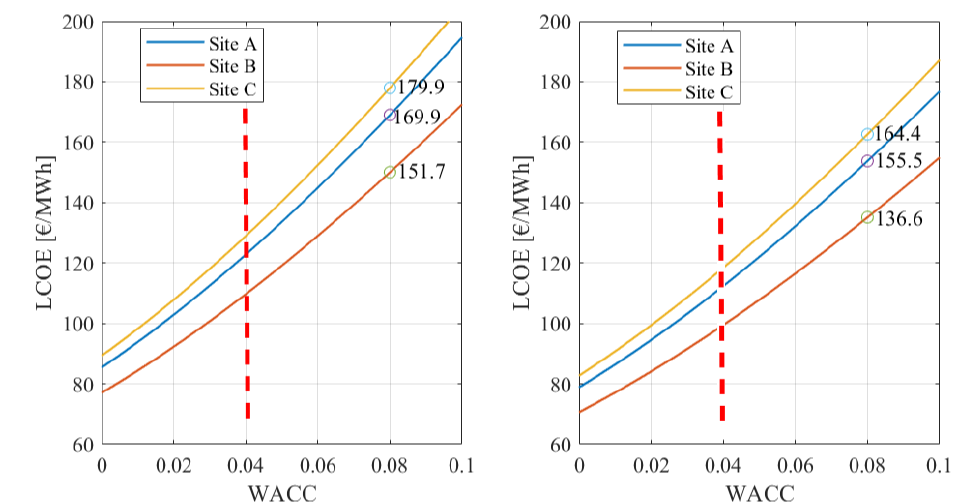
Figure 19. Influence of WACC for sites A, B, and C for both concepts.